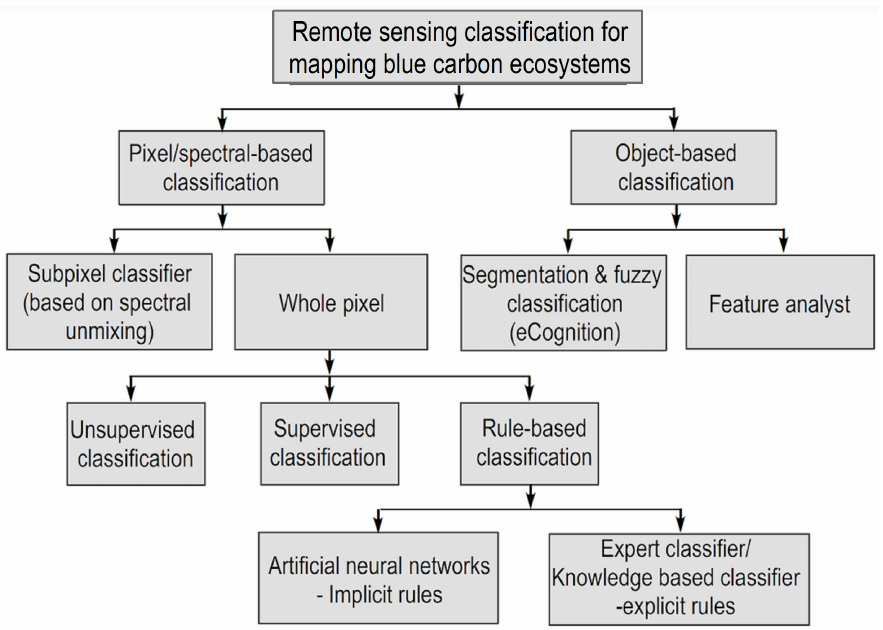
Figure 5. Illustration of classification methods for mapping blue carbon